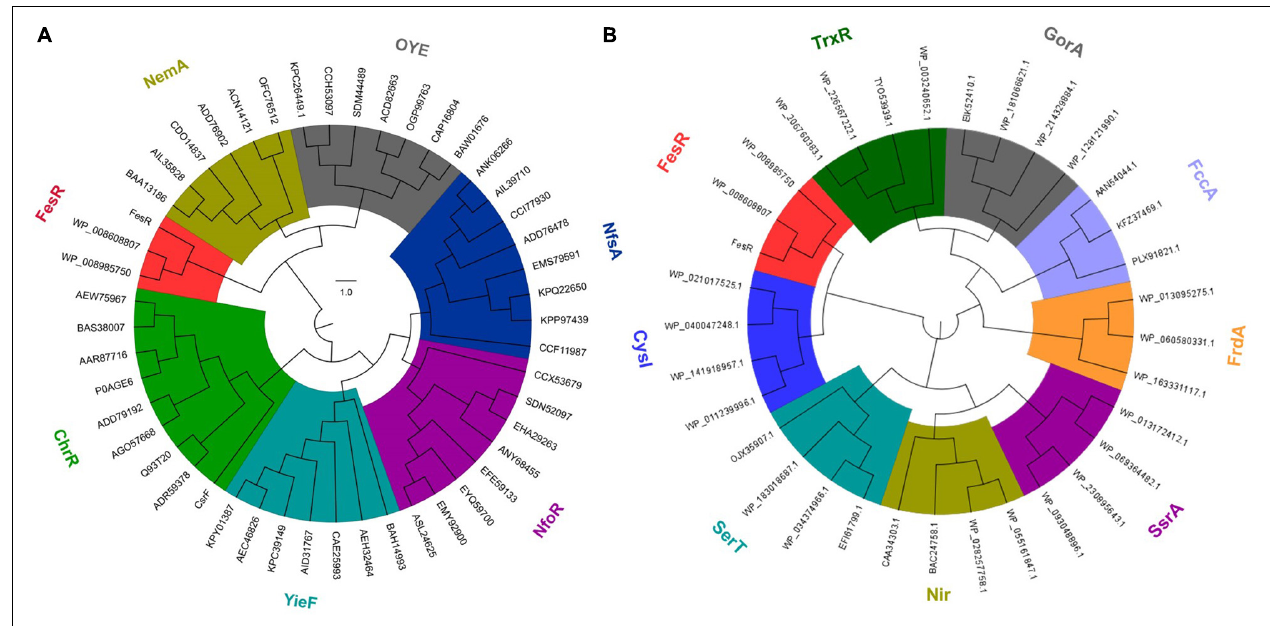
FIGURE 2 | Evolutionary relationship of FesR with the reported aerobic chromate and selenite reductases. FesR and its similar proteins in other Alishewanella strains were separated from other chromates (NemA, OYE, NfsA, NfoR, YieF, and ChrR) reductase families (A) and selenite (TrxR, GorA, FccA, FrdA, SsrA, Nir, SerT and CysI) reductase families (B)